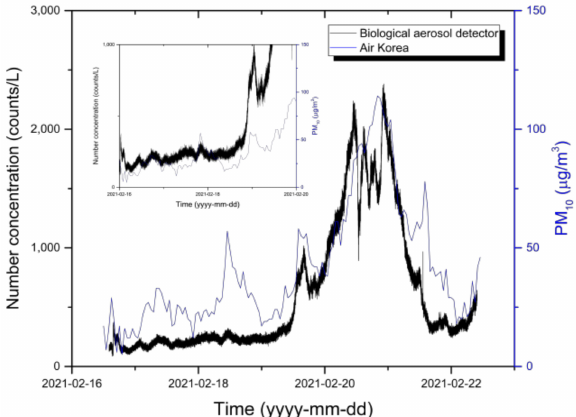
Figure 2. The location of the observation station of Air Korea and the outdoor particle observation station of the biological particle detector used in this study.